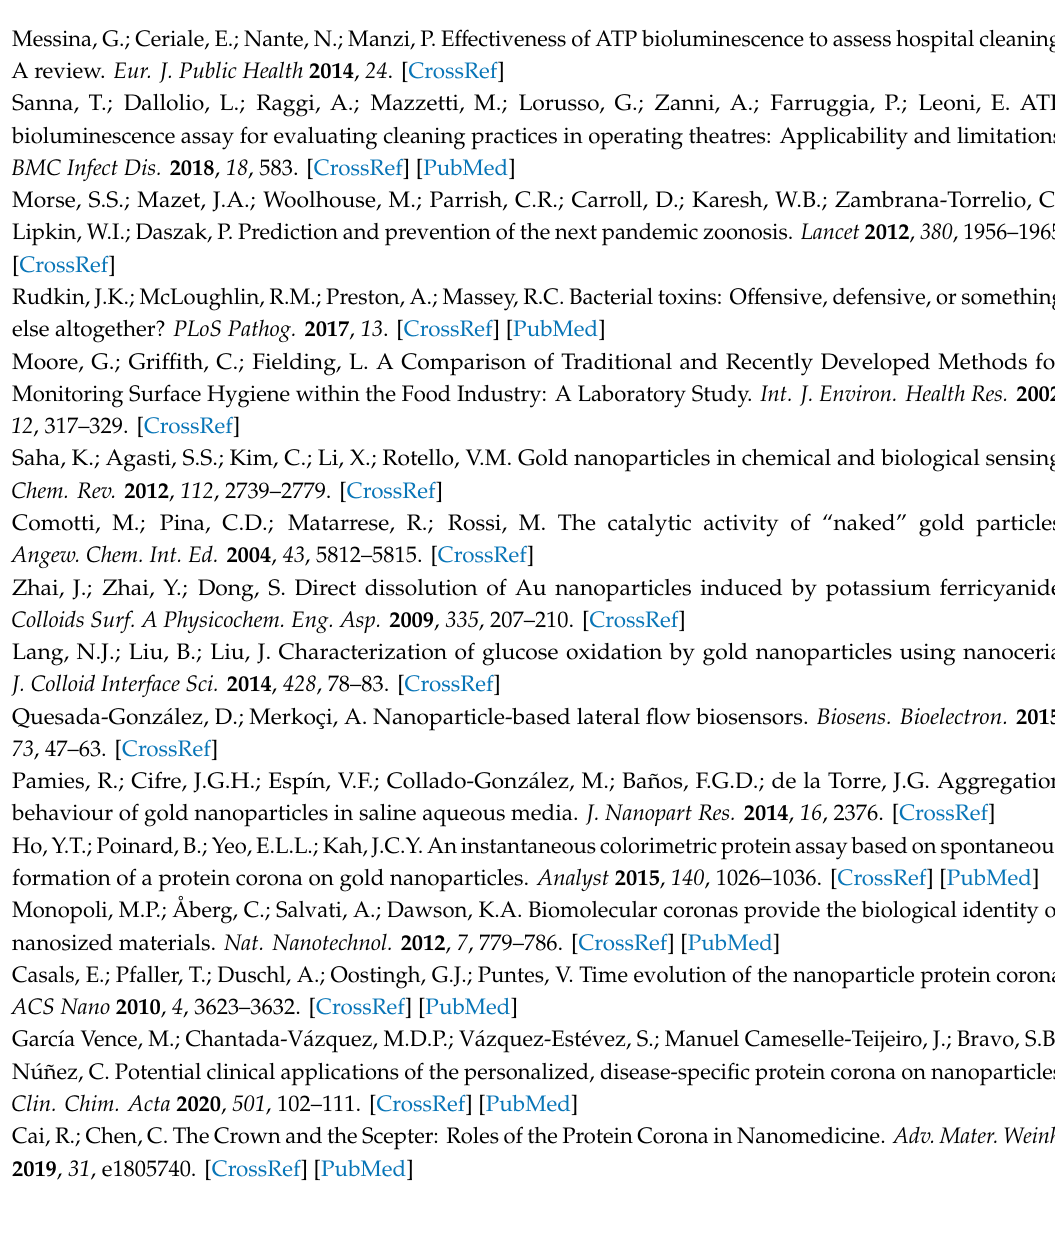
Figure S1: Fluorescence kinetics of samples containing AuNPs and BSA-Alexa Fluor ® , Figure S2: Calibration curve for BSA-Alexa Fluor ® , Figure S3: Characterization of protein-coated AuNPs, Figure S4: UV-vis spectra of protein-coated AuNPs centrifuged and resuspended in protein-free media after reaction with 1 mM ferricyanide, Figure S5: SEM images of the plasmonic paper, Figure S6: EDX spectra of plasmonic papers exposed to ferricyanide with